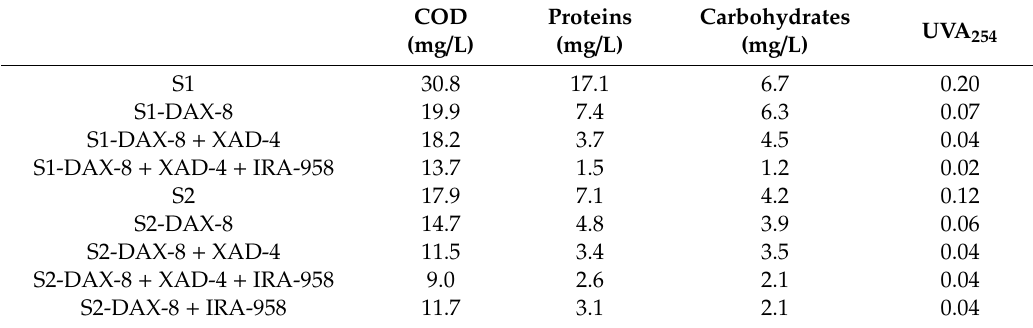
Table 3. Characteristics of the different streams in the fractionation experiments of the secondary effluents.